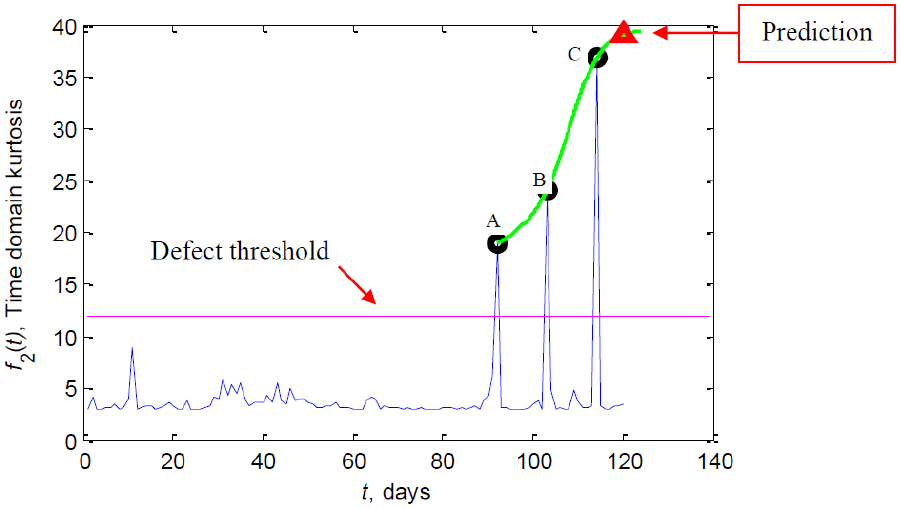
Figure 6. One-step-ahead prediction of time-domain kurtosis feature.